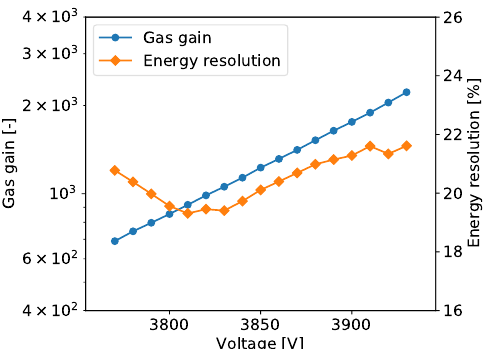
Figure 21. Standard GEM detector with copper foils E . Gas gain and energy resolution vs. detector bias voltage.